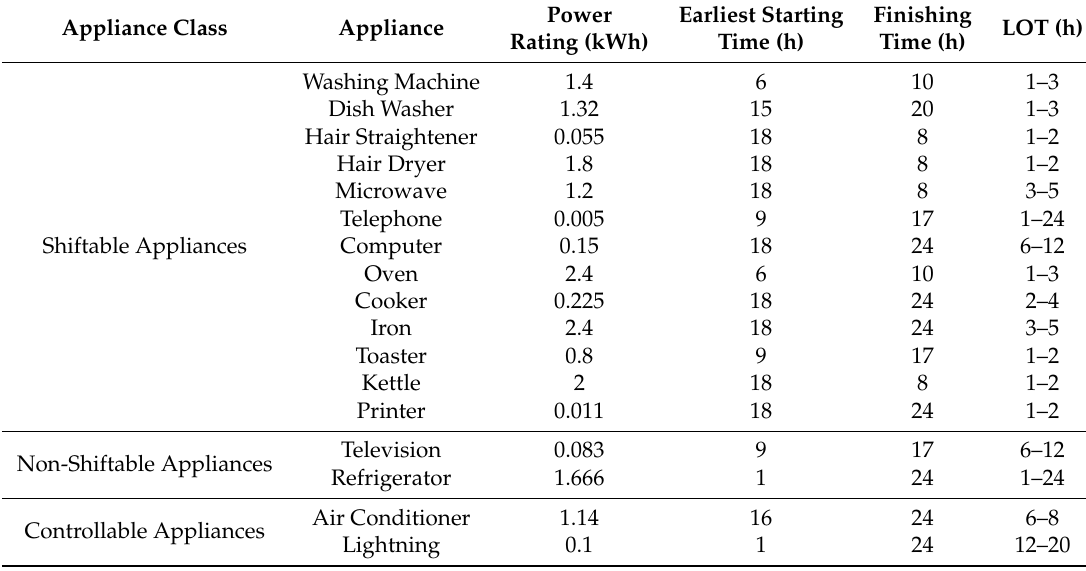
Table 4. Parameters of